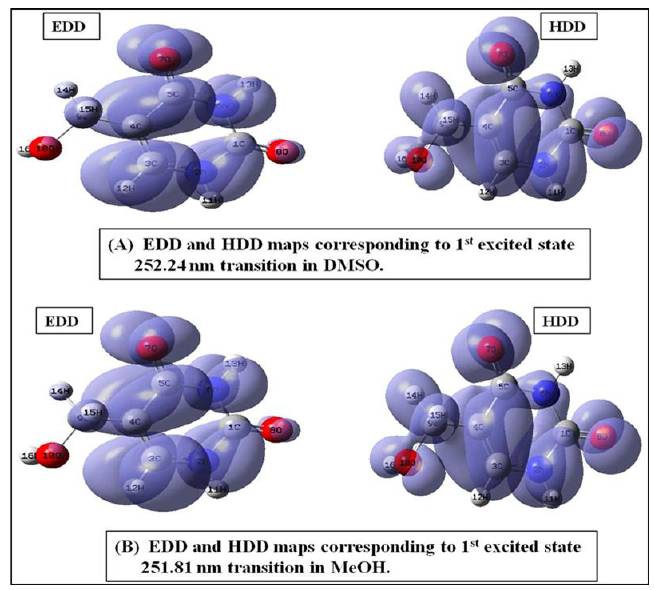
Figure 9 . EDD and HDD maps of the excited state of 5-HMU in ( A ) DMSO and ( B ) methanol. Figure 9. EDD and HDD maps of the excited state of 5-HMU in ( A ) DMSO and ( B )